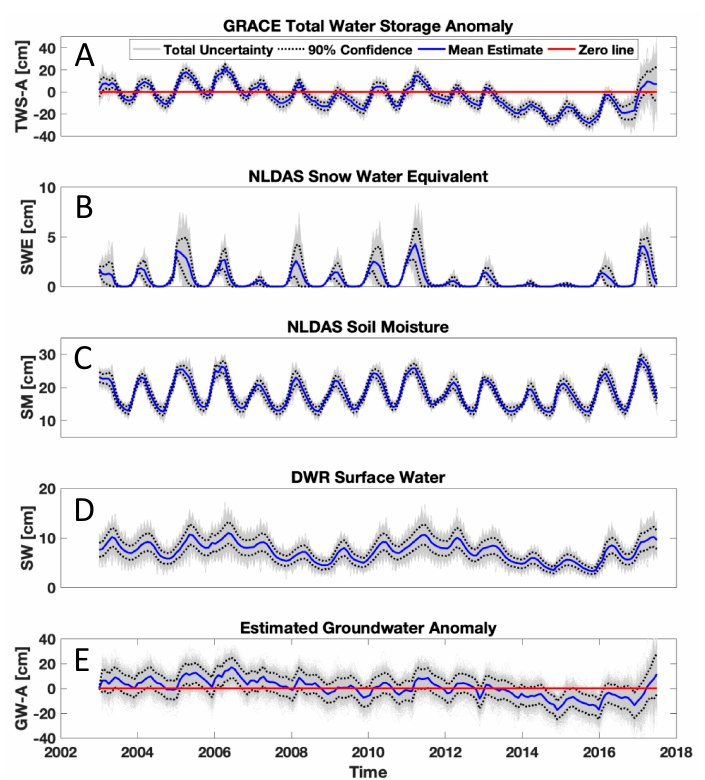
Figure 3. Temporal dynamics with uncertainties for all water processes in California that are investigated in this study, including ( A ) TWS from GRACE, ( B ) SWE from NLDAS, ( C ) soil moisture from NLDAS, ( D ) reservoir storage from DWR, and ( E ) estimated groundwater anomalies calculated in this study.